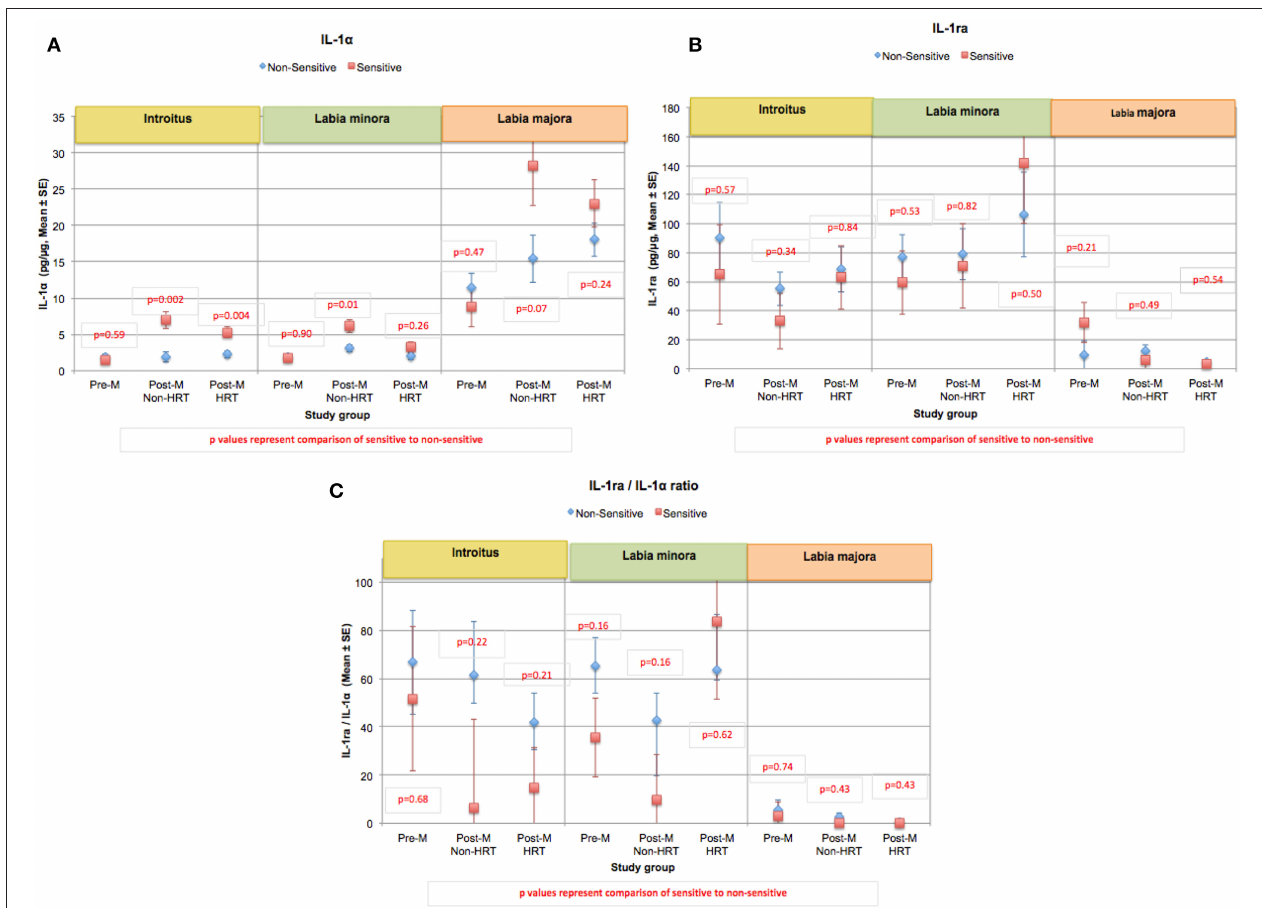
FIGURE 8 | Content of IL-1 α , IL-1ra, and the ratio of IL-1ra/IL-1 α at genital sites among women with sensitive genital skin. In the study to evaluate biomolecular and physical measures of the urogenital skin, sequential tape strips were used to collect material for the quantitative analysis of a variety of biomarkers and cytokines. Results of analyses of: (A) IL-1 α , (B) IL-1ra, and (C) the ratio of IL-1ra/IL-1 α are presented for each group. For each group, the mean value for those who did not have sensitive genital skin was compared to those declaring sensitive skin using a mixed linear model. (A) Mean IL-1 α , (B) mean IL-1ra, (C) mean of the ratios of IL-1ra/IL-1 α